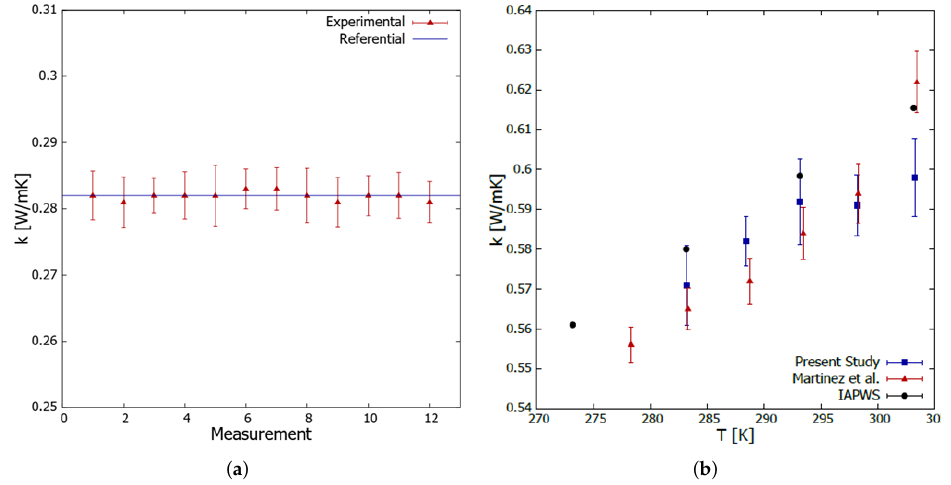
Figure 1. ( a ) Traceability test results of the KS-1 probe with glycerin. The error bars correspond to the KD2-Pro measurement error. ( b ) Assessment of the accuracy of the implemented transient hotwire method. The error bars correspond to the measurements standard